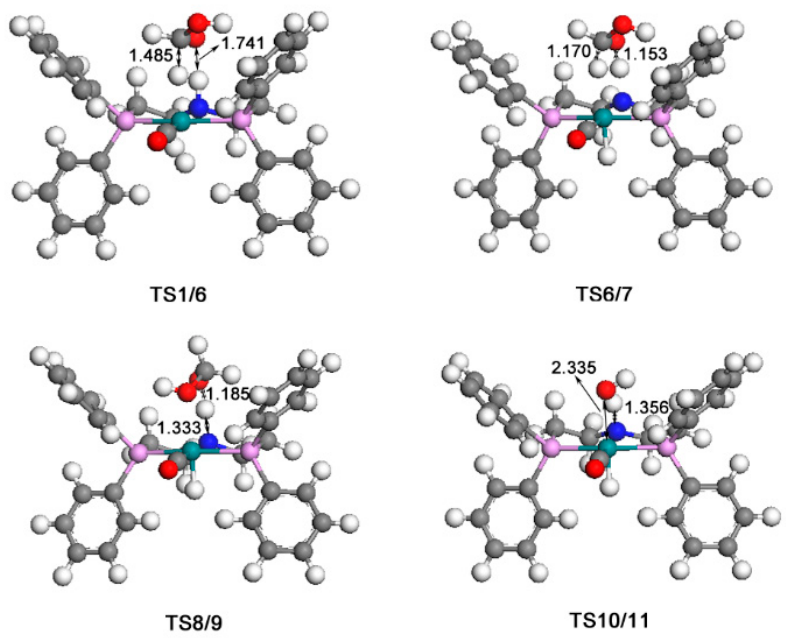
Figure 6. Optimized structures of TS1/6(432i cm − 1 ), TS6/7(644i cm − 1 ), TS8/9 (839i cm − 1 ), TS10/11 (1008i cm − 1 ). The unit of bond lengths is expressed in angstrom (Å). (Green balls: Ru; pink: P; red: O; blue: N; grey: C; white: H).